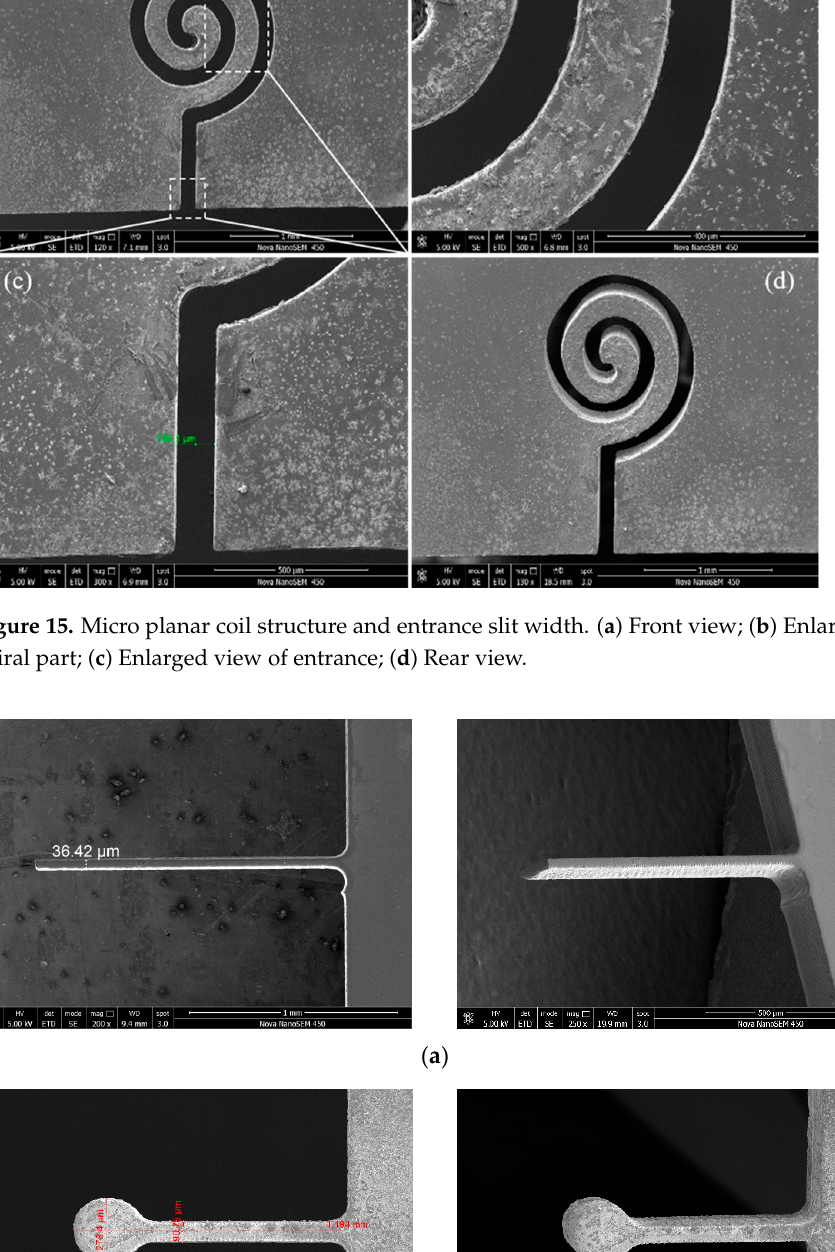
Figure 16. Structure of typical glass microcantilever. ( a ) Structure of glass columnar microcantilever. ( b ) Structure of glass disc-free end microcantilever.